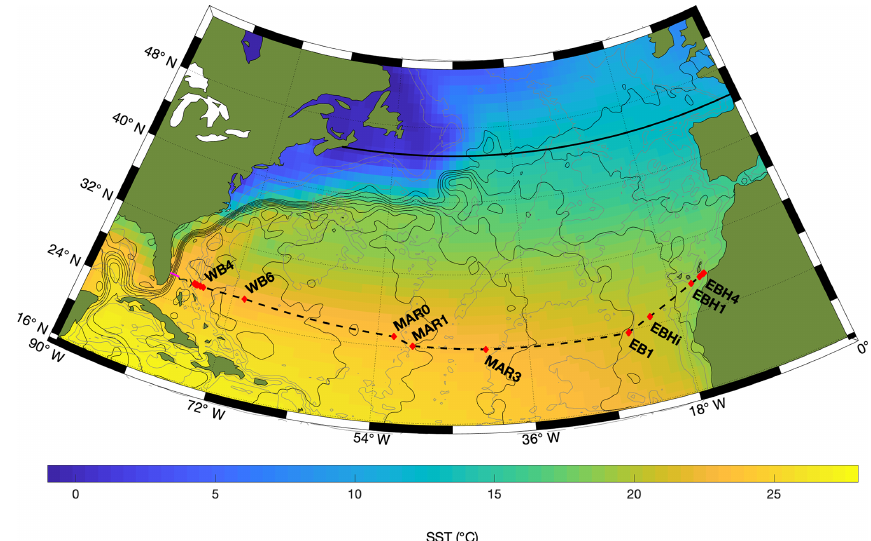
Figure 1. The RAPID 26 ◦ N array traverses the subtropical gyre of the North Atlantic. The magenta line shows the location of the subsea cable in the Florida Straits, and red diamonds connected by a dashed black line show the locations of moorings. “WB”, “MAR” and “EB” denote, respectively, moorings in the western boundary, Mid-Atlantic Ridge and eastern boundary sub-arrays. For clarity, not all moorings are labelled. The colour shows mean sea surface temperature (SST) in March (average of 1999 to 2018) and the continuous black lines are the corresponding contours of sea surface height (contour interval 0.1m). Contours of water depth at 1000, 3000 and 5000m are shown in grey. The thick black line at 45 ◦ N indicates where multiple data sources have been used to estimate the AMOC at the boundary between the subtropical and subpolar gyres (Desbruyères et al.,